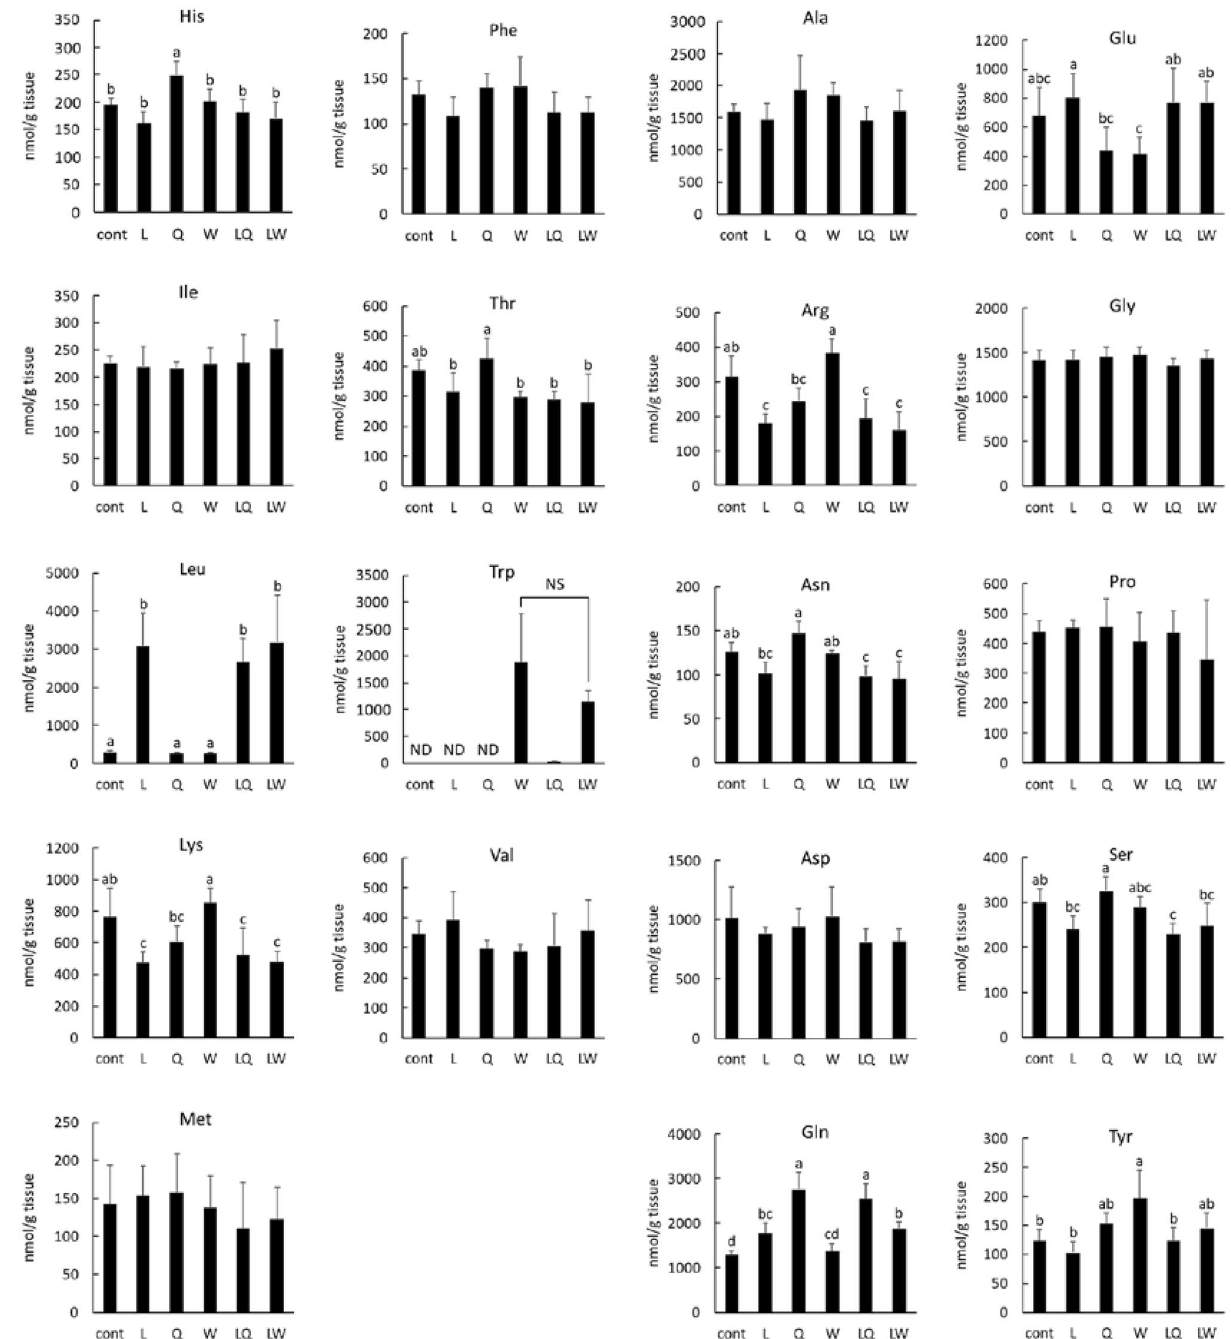
Figure 5. Amino acid concentrations in the gastrocnemius muscle of mice administered 0.2% xanthan gum solution (Cont), leucine (L), glutamine (Q), tryptophan (W), leucine + glutamine (LQ), or leucine + tryptophan (LW) by gavage after 24 h fasting. Data are expressed as the mean ± SD (n = 5); except for tryptophan concentration in the LQ group, where n = 1, as tryptophan was not detected in other samples. a,b,c,d Mean values denoted by different letters represent significant difference between the groups (P < 0.05). Mean values without letters are not significantly different among groups (P > 0.05). ND not detected, NS not